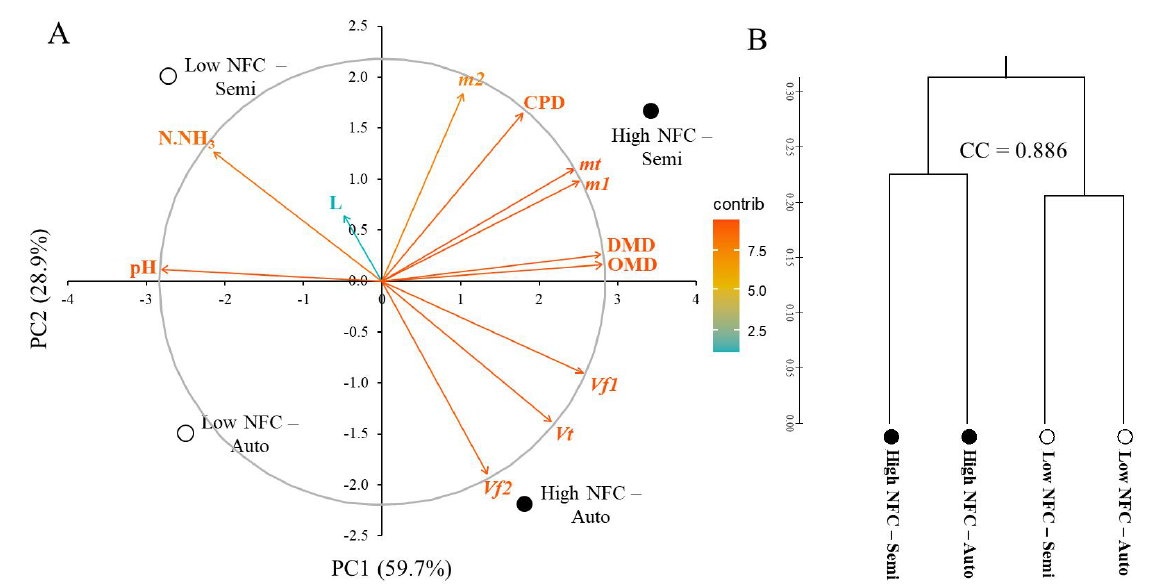
Figure 4. Principal component analysis and dendrogram for estimating in vitro gas production parameters, ruminal parameters and nutrient degradability from two diets as a function of two gas production measurement techniques. ( A ) Circle correlation of 12 characteristics and treatment dispersion as a function of the first two components. The arrows represent the direction of the characteristic and the color gradient represents the contribution of each characteristic to the components; from blue to red: low to high contribution. ( B ) Dendrogram obtained by the UPGMA clustering method based on the Gower distance.